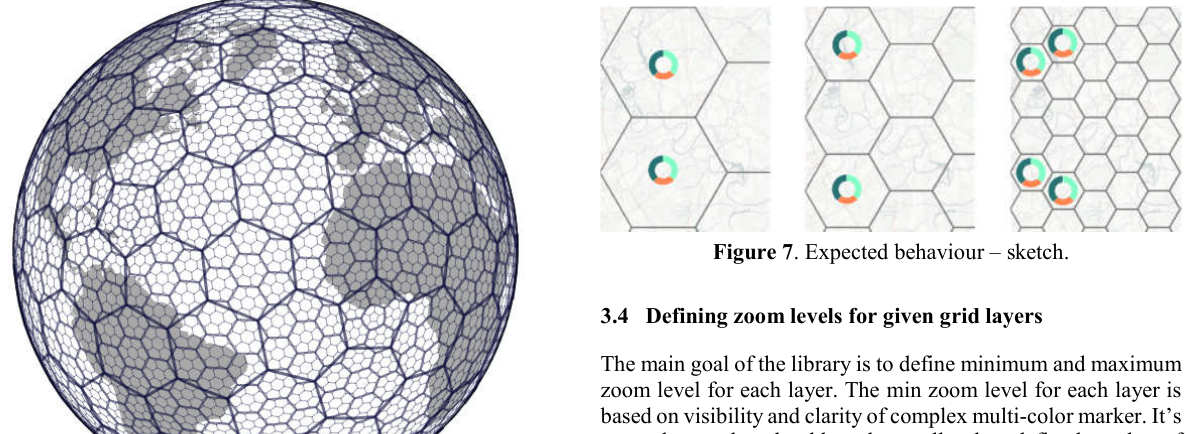
The main goal of the library is to define minimum and maximum zoom level for each layer. The min zoom level for each layer is based on visibility and clarity of complex multi-color marker. It’s mean that marker should not be smaller than defined number of pixels (that should be defined empirically based on map content and color). If we use a hexagonal grid, the size of the marker is equal to the inscribed circle radius of the hexagon cell (Figure 8). Figure 6 . Representation of H3 grid on a planet scale (Brodsky, 2019).